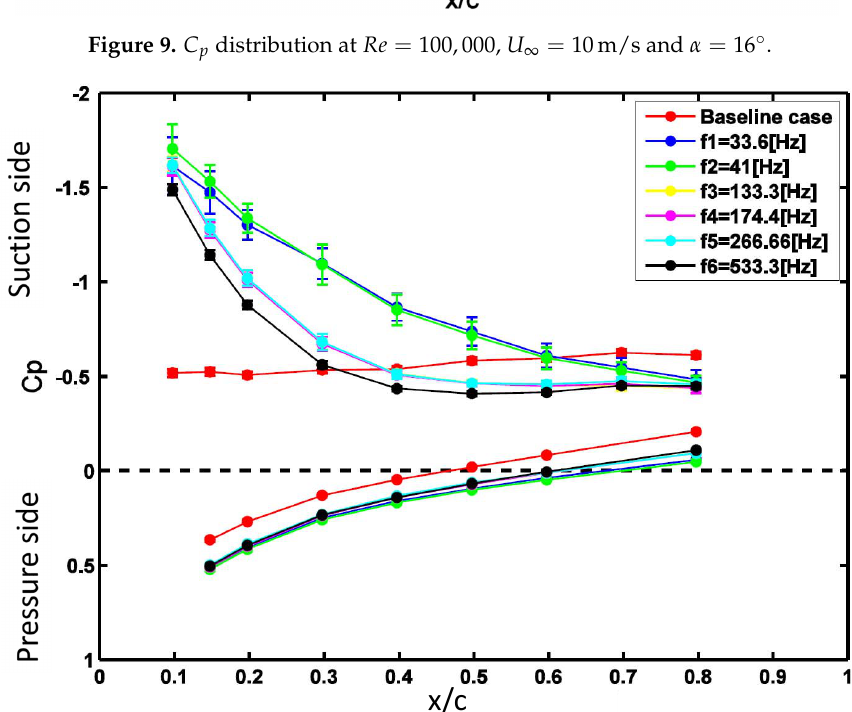
Figure 10. C p distribution at Re = 200,000, U ∞ = 20m/s and α = 16 ◦